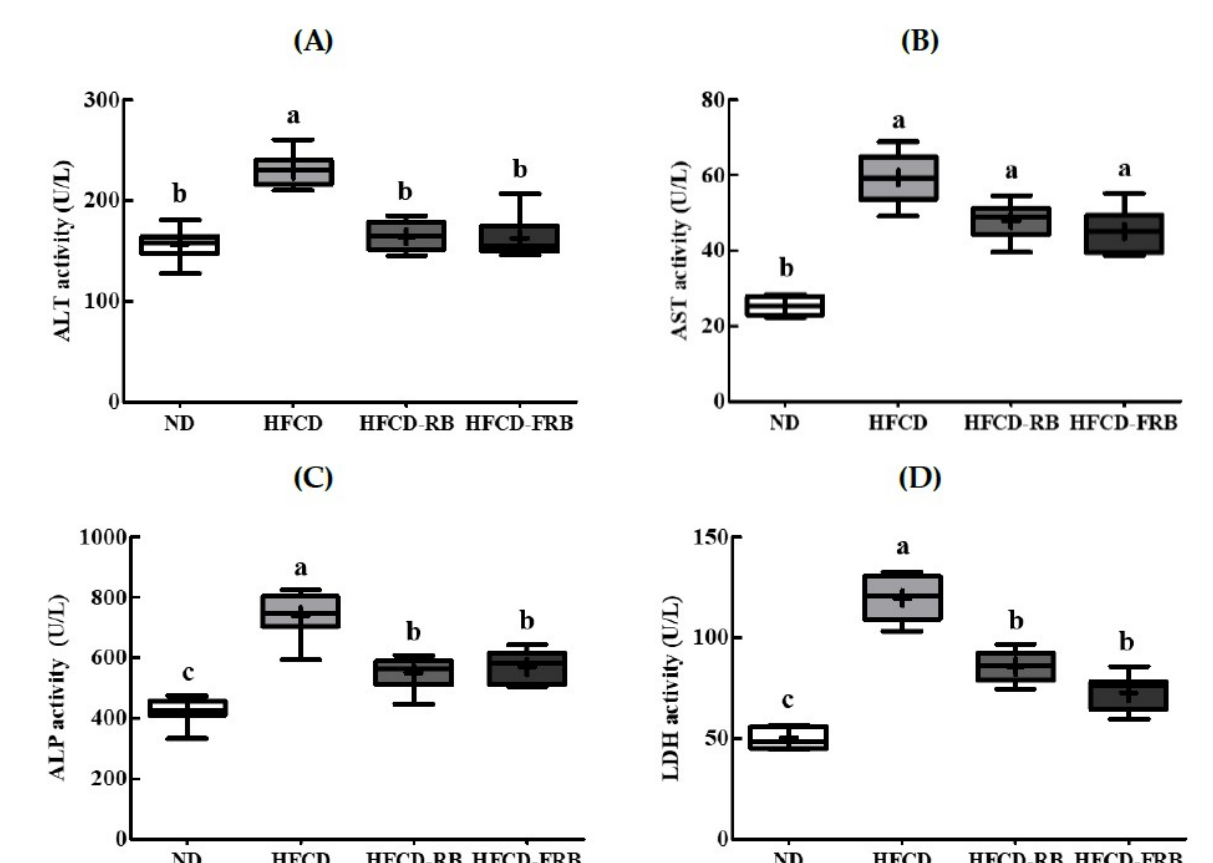
Figure 3. Biochemistry markers of hepatic function in mice fed experimental diets for 10 weeks. Diet groups: ND, normal diet group; HFCD, high-fat and -cholesterol diet group; HFD-RB, HFCD + non-fermented rice bran powder group; HFCD- FCA, HFCD + fermented rice bran powder group. ( A ) Alanine aminotransferase (ALT), ( B ) aspartate aminotransferase (AST), ( C ) alkaline phosphatase (ALP), and ( D ) lactate dehydrogenase (LDH) activities were analyzed biochemically. Values are displayed as a Box-and-Whisker plot with means (expressed as ‘+’), n = 10. a-c: bars with different letters are significantly different at p < 0.05 by Tukey’s post hoc test.